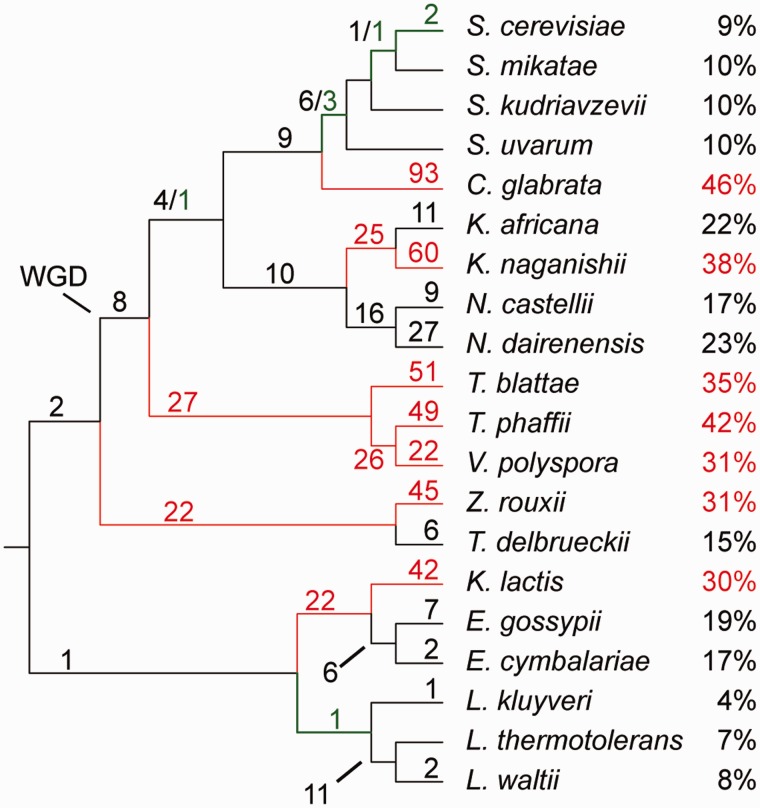
Tree displaying mapped intron gains and losses in YGOB species. The number above a branch indicates gain (green) and loss (red/black) on this branch. The number above a tip indicates gain/losses that happened in each species. Branches with more than 20 losses and species with more than 40 losses are displayed in red. The percentages on the right represent the proportion of genes with lost introns. The tree topology was taken from YGOB ver 7 (Byrne and Wolfe 2005) after Hedtke et al. (2006).